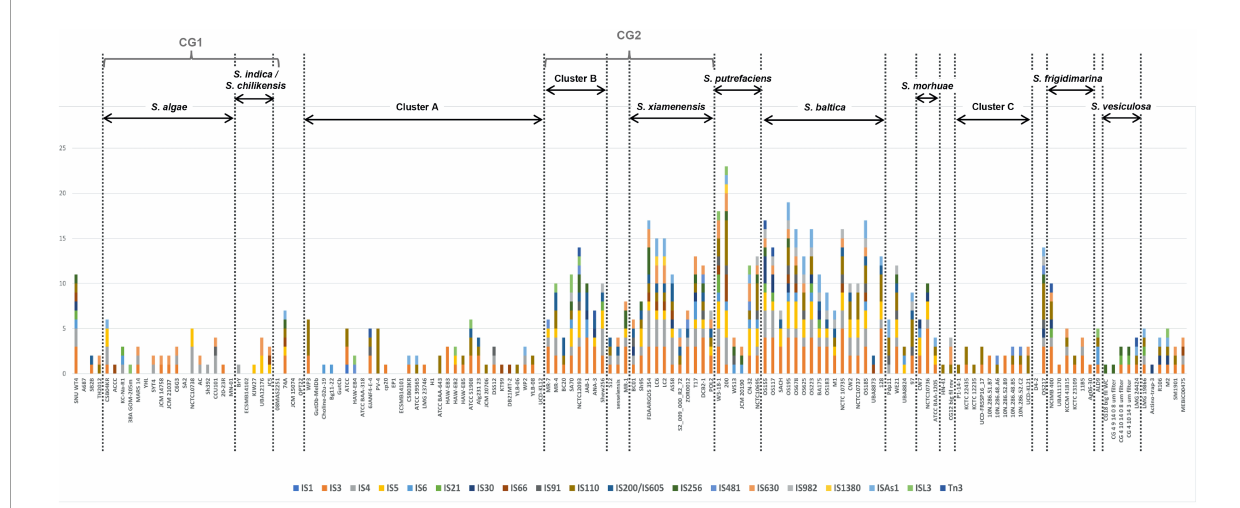
FIGURE4 Insertion sequence families found in Shewanella spp. genomes. Genomes ( n = 144) were sorted according to the phylogenetic tree. Vertical dotted lines separate the different lineages and clusters. Y -axis depicts the number of non-redundant ISs ( n = 178) found in Shewanella spp. genomes. Colored bars represent each IS family ( n = 19); each family can have > 1 IS ( Supplementary Table 10 ).